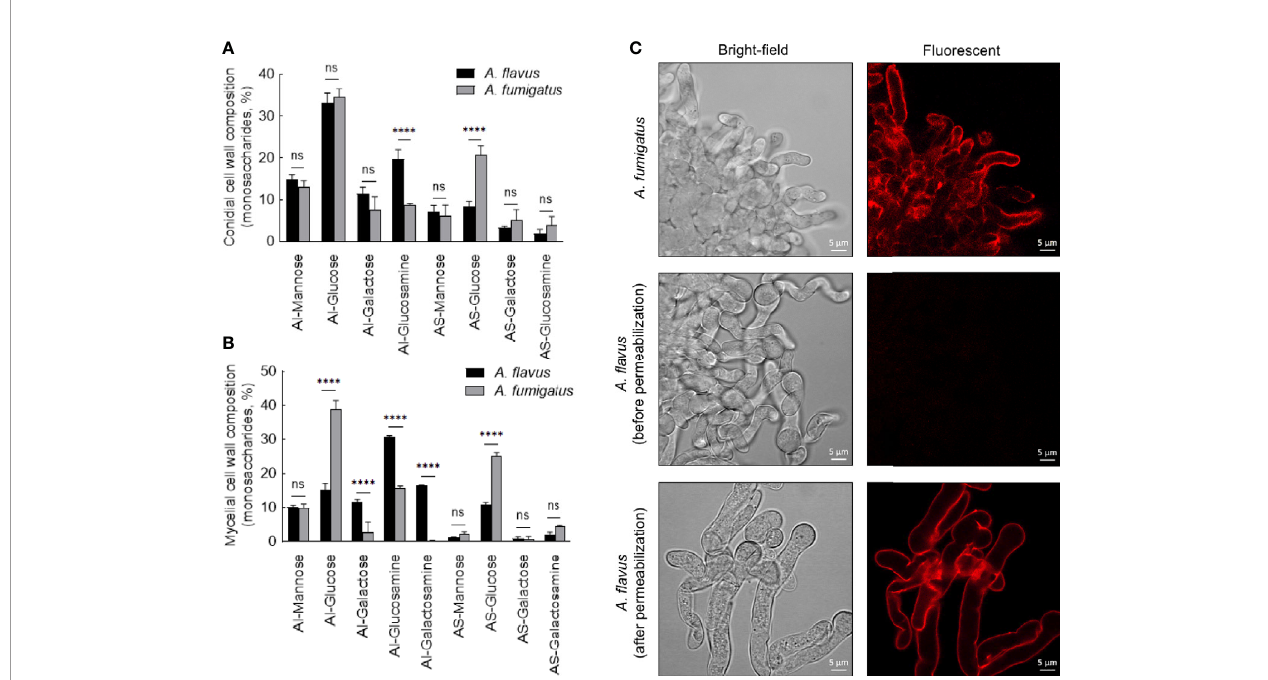
FIGURE 5 | Conidial (A) and mycelial (B) cell wall composition in the two Aspergillus species. The alkali-insoluble (AI) fraction containing fi brillar polysaccharides and alkali-soluble (AS) fraction with amorphous component were subjected to gas-liquid chromatography after derivatization, to determine their monosaccharide compositions (three biological replicates; ****p < 0.0005, ns – not signi fi cant, error bars – standard deviation). (C) Localization of galactosaminogalactan (GAG). Monoclonal anti-GAG antibody was added to the germinating conidia, with or without cell wall permeabilization by Glucanex, followed by incubation with anti-mouse IgG conjugated to